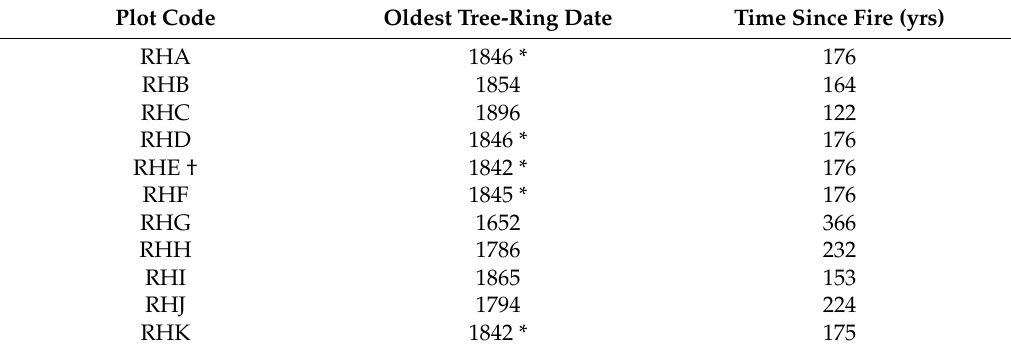
Table 4. The upper-elevation forest-age plot maximum trees ages for the upper Rio Hondo watershed. The time since fire was calculated from 2018.